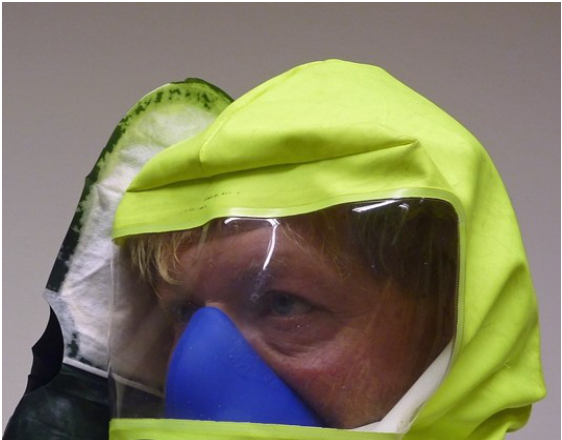
Figure 2. Decontamination of a protective mask with a FAST-ACT decontamination glove